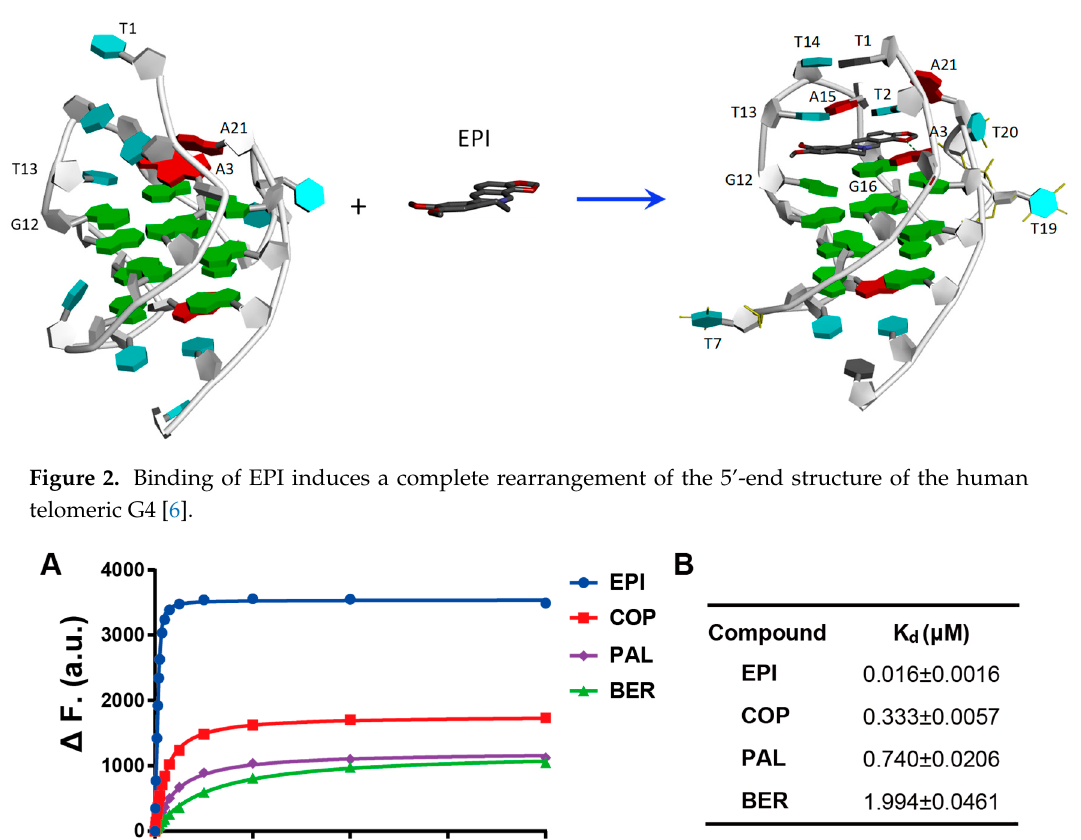
Table 1. MM ‐ GBSA binding free energies and their components computed using the bsc0 force field [23]. Units: kcal/mol.